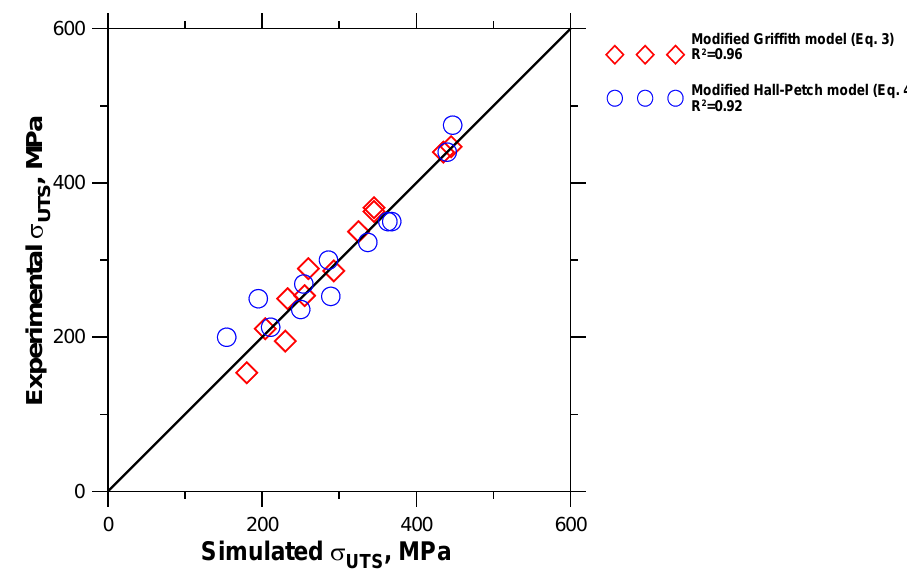
Figure 11. Correlation between measured and simulated UTS values.